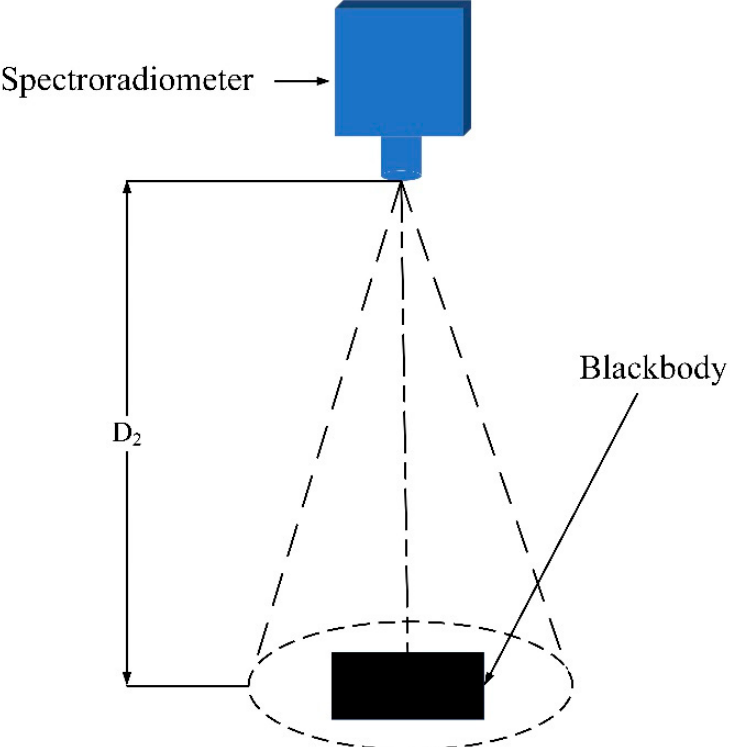
Figure 3. Schematic diagram of experiment to verify the effect of the spatial nonuniformity correction of the spectrometer FOV. Table 1. FOV nonuniformity correction verification